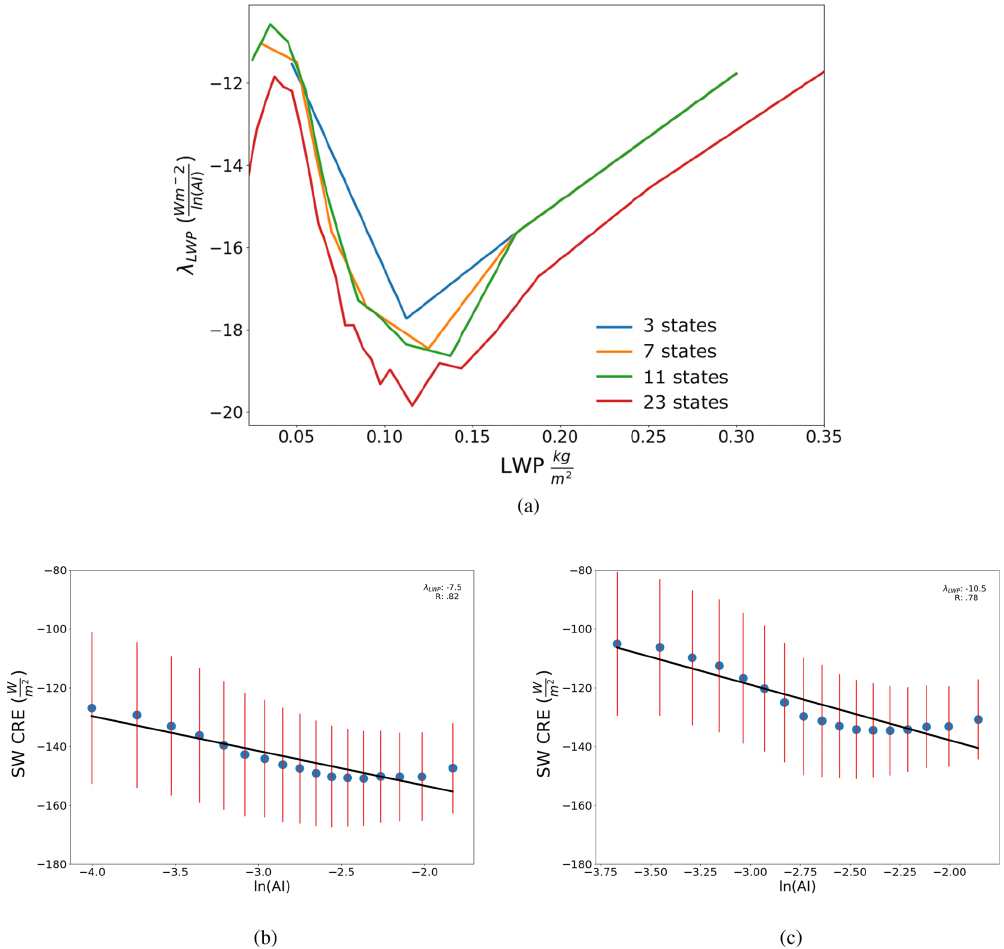
Figure 2. Values of the sensitivity of CRE to aerosol ( λ LWP from Eq. 5) for different resolutions of cloud state regimes. The weighted, summed λ LWP is − 13 . 12Wm − 2 ln(AI) − 1 with eight partitions. Plots of warm cloud shortwave CRE against ln(AI) are shown below for (b) thin (0.04 to 0.06kgm − 2 ) and (c) thick (0.1 to 0.15kgm − 2 ) cloud states. The red lines represent the standard deviation within each ln(AI) bin and the blue dots represent the mean SW CRE for each ln(AI) bin in plots (b) and (c)